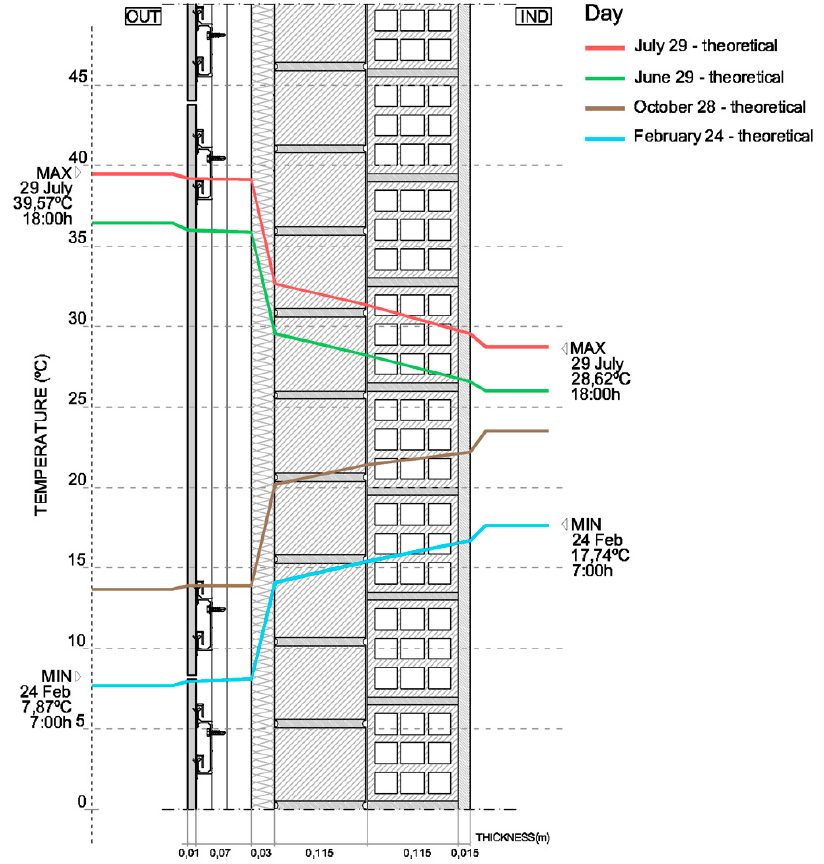
Figure 12. Dynamic temperature graphs of the enclosure measured according to Fourier’s law, for λ values of the Mathis TCi unit and thickness of the project layers, on the less favourable days in each season.